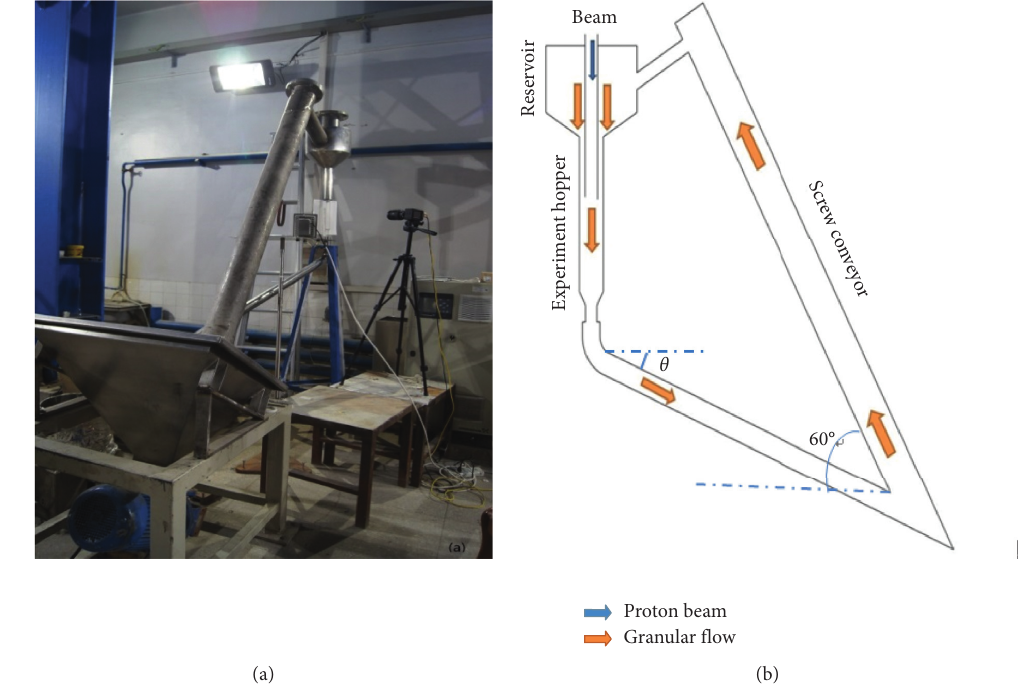
Figure 1: (a) The experimental loop of granular flow; (b) a schematic of the granular loop.